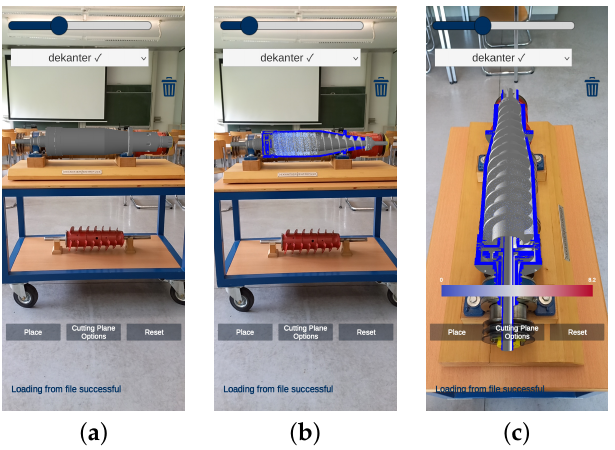
Figure 23. Results of geometry overlay using a decanter centrifuge as an example. ( a ) Decanter front uncut. ( b ) Cooling truck front cut. ( c ) Cooling truck top